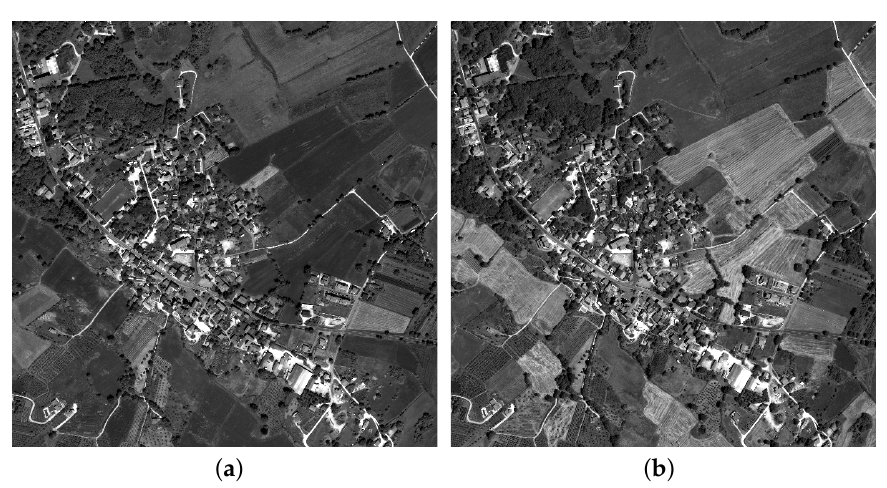
Figure 2. The 2048 × 2048 details of the GeoEye-1 Pan images taken on ( a ) 27 May 2010, ( b ) 13 July